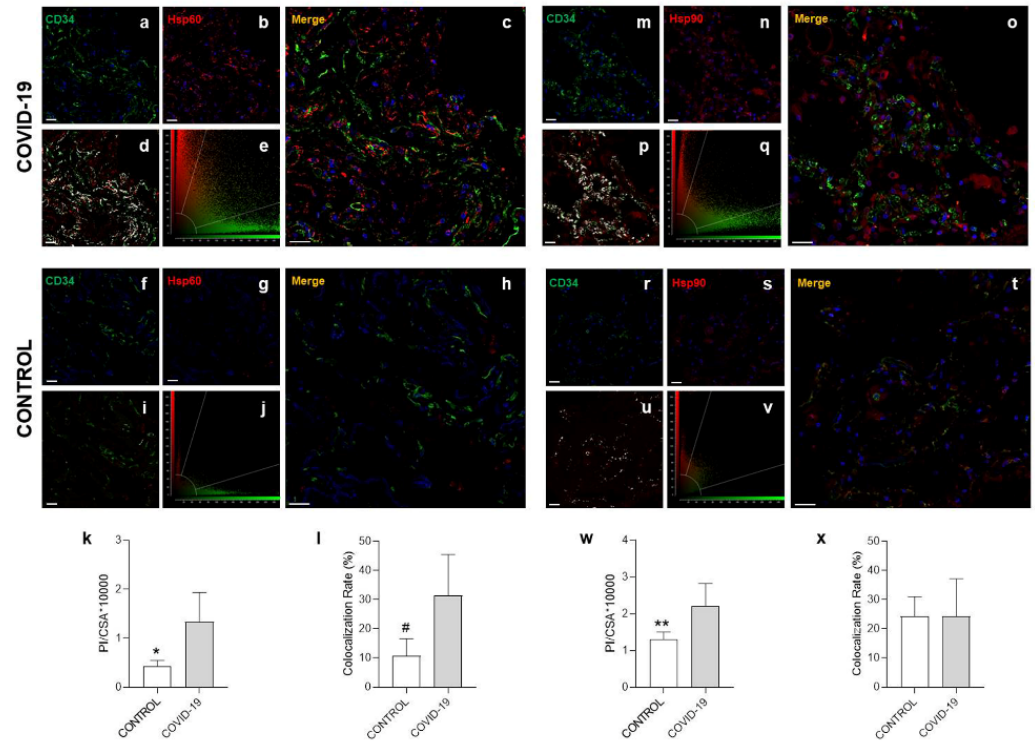
Figure 3. Confocal microscopy analysis demonstrated that Hsp60 and Hsp90 tissue levels increased in the COVID-19 group compared to the control lungs. ( a – e , m – q ) Representative images of COVID-19 lung parenchyma. ( a , b , m , n ) Representative immunofluorescence for CD34 (( a , m ) green), Hsp60 (( b ), red), and Hsp90 (( n ), red); nuclei stained with DAPI are shown in blue. ( c , o ) The panels show the merged confocal laser scanning image of CD34/Hsp60 ( c ), CD34/Hsp90 ( o ), and nuclei. ( d , p ) Merged images show colocalization between CD34 and Hsp60 (( d ), white) and between CD34 and Hsp90 (( p ), white). ( e , q ) Semiquantification of colocalization parameters between CD34 and Hsp60 ( e ) and between CD34 and Hsp90 ( q ) by a cytofluorogram. ( f – j , r – v ) Representative images of control lung parenchyma. ( f , g , r , s ) Representative immunofluorescence for CD34 (( f , r ) green), Hsp60 (( g ), red), and Hsp90 (( s ), red); nuclei stained with DAPI are shown in blue. ( h , t ) The panels show the merged confocal laser scanning image of CD34/Hsp60 ( h ), CD34/Hsp90 ( t ), and nuclei. ( i , u ) Merged images show colocalization between CD34 and Hsp60 (( i ), white) and between CD34 and Hsp90 (( u ), white). ( j , v ) Semiquantification of colocalization parameters between CD34 and Hsp60 ( j ) and between CD34 and Hsp90 ( v ) by a cytofluorogram. ( k , w ) The staining intensity for Hsp60 ( k ) and Hsp90 ( w ) (bars) expressed as the mean pixel intensity (PI) normalized to the cross-sectional area (CSA) using the Leica Application Suite Advanced Fluorescence software. ( l , x ) The bar graph shows the colocalization ratio (%) between CD34 and Hsp60 ( l ) and between CD34 and Hsp90 ( x ). Open bar, control; shaded bar, COVID-19. Data are presented as the means ± SD. * significantly different from COVID-19 group ( p = 0.0256). # significantly different from COVID-19 group ( p = 0.0192). ** significantly different from COVID-19 group ( p = 0.0280). Scale bar 25 µ